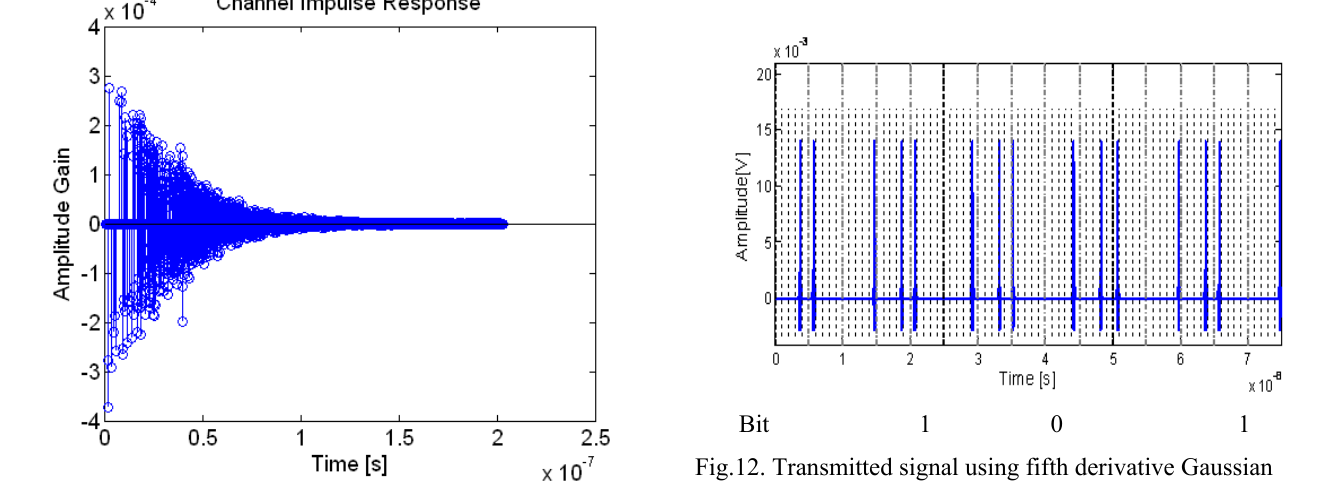
Fig.10. Channel Impulse response of UWB CM3